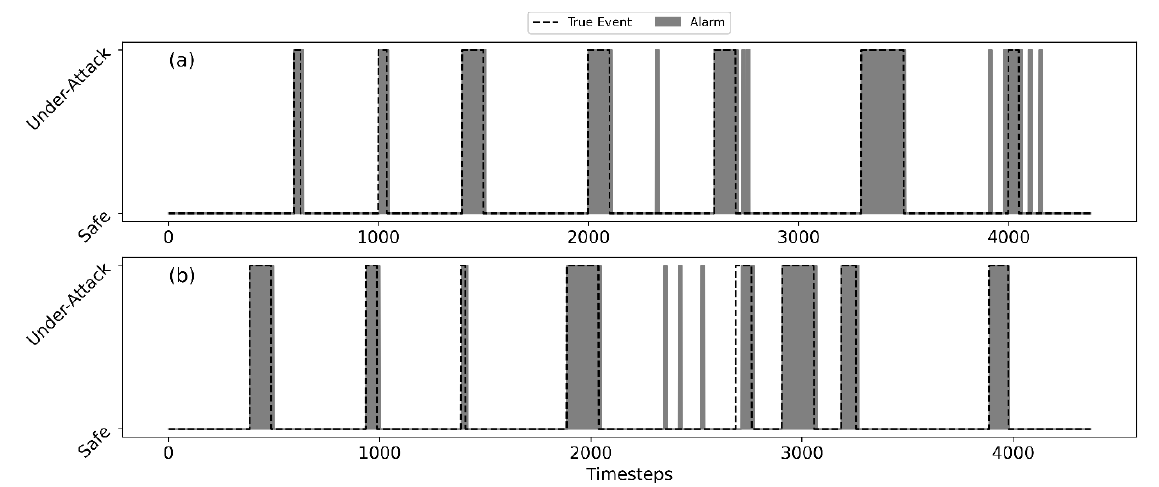
Figure 10. SSDS Detection performance; flags in gray, true events in dashed line. E-Town: Test 1 ( a ) and Test 2 ( b ).